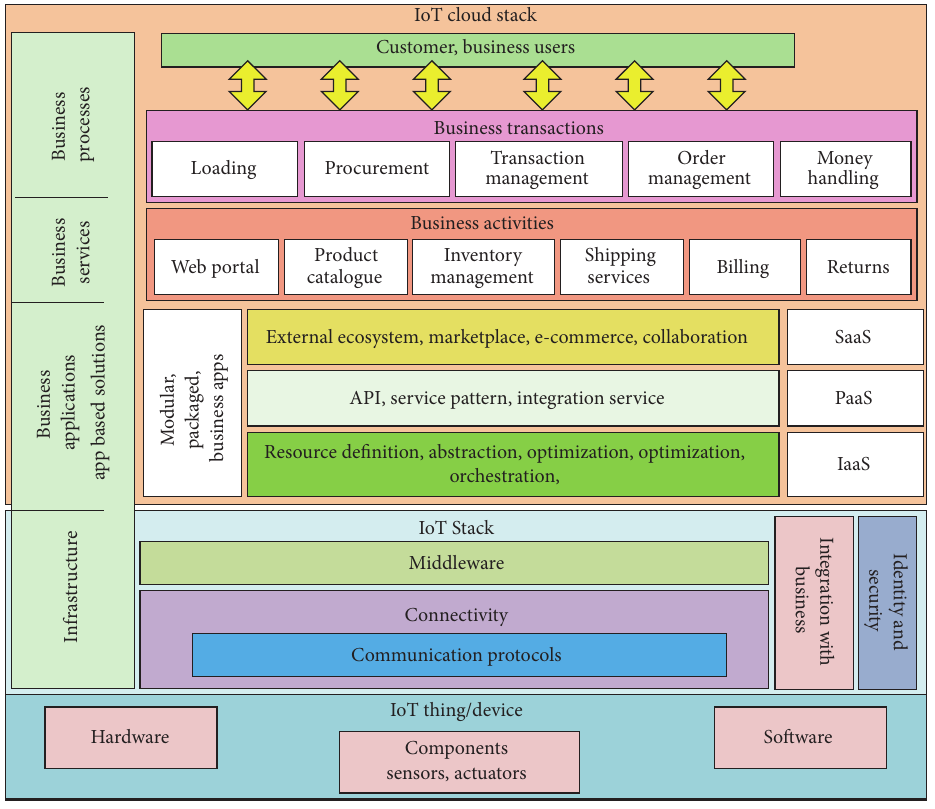
Figure 3: IoT cloud stack based on IoT